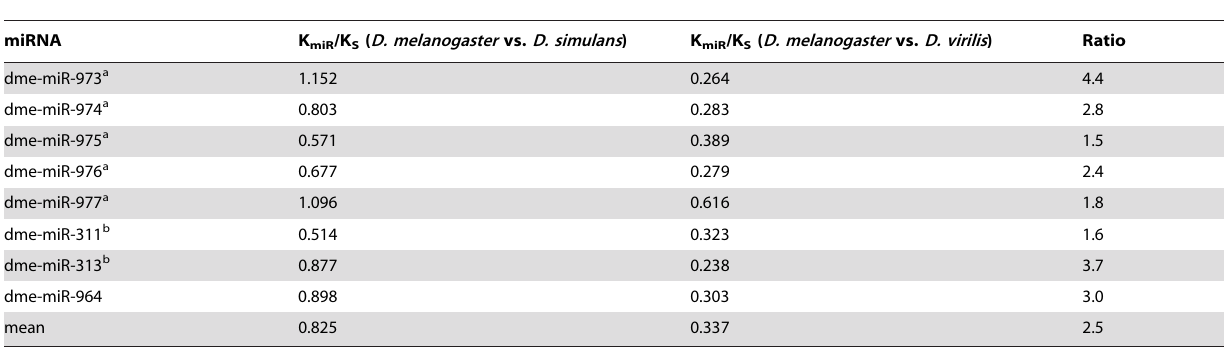
Table 4. K miR /K S of the older miRNAs (60–250 Myrs) that have been evolving rapidly between D. melanogaster and D. simulans .